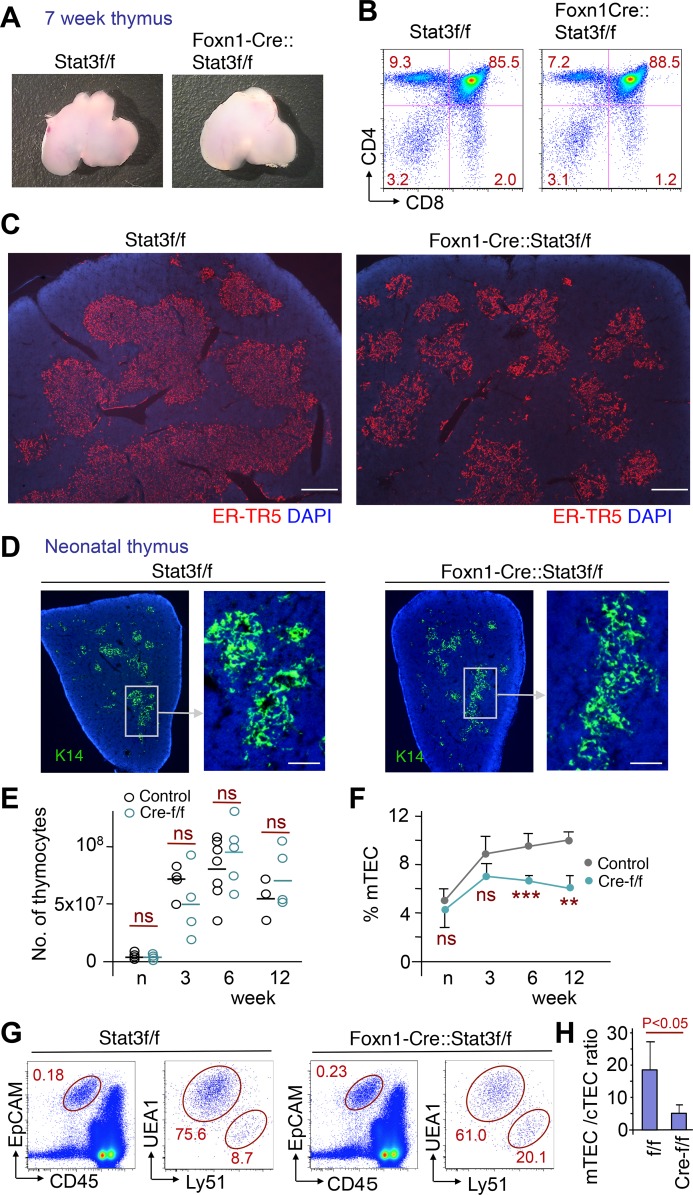
Medullary regions are severely affected in Foxn1-Stat3-CKO mice.(A) Macroscopy of the thymus derived from Stat3-flox/flox (Stat3f/f) and Foxn1Cre::Stat3f/f mice at 7 weeks of age. (B) Flowcytometric profiles of developing thymocytes derived from Stat3f/f and Foxn1Cre::Stat3f/f mice, at 7 weeks of age. (C) Cryostat sections of thymic tissue from Stat3f/f and Foxn1Cre::Stat3f/f mice (7 weeks of age) were stained with the mTEC specific antibody, ER-TR5 (red) and counterstained with DAPI (blue). Scale bars: 400 μm. (D) Cryostat sections of neonatal thymic tissue from Stat3f/f and Foxn1Cre::Stat3f/f mice were stained with antibody directed to K14 (green) and counterstained with DAPI (blue) Scale bars: 100 μm. (E) Total thymic cellularity of control (containing Cre-f/+ and f/f) and Foxn1Cre::Stat3f/f (Cre-f/f) mice at indicated ages. Bar stands for the average value of each experimental group. ns denotes a non-significant difference (P>0.1) in Student’s t test. (F) Changes in the proportional area of medullary regions in thymus tissue sections of control (containing Cre-f/+ and f/f, n = 8, 6, 7, 3 for neo, 3, 6, 12 week, respectively) and Foxn1Cre::Stat3f/f (Cre-f/f, n = 5, 4, 6, 5 for neo, 3, 6, 12 week, respectively) mice in the first 12 weeks of life. The area occupied by mTECs in thymus was quantitatively measured in sections stained with K14 antibody using Axiovision4 software (Carl Zeiss). Error bar stands for the standard deviation. ns denotes a non-significant difference (P>0.1) in Student’s t test. **;P<0.005, ***;P<0.0005. (G) Representative flow cytometric profiles showing frequencies of major TEC populations from 12 weeks old Stat3f/f and Foxn1Cre::Stat3f/f mice. EpCAM+CD45- fraction represents whole TEC population, and UEA1 vs Ly51 profile was displayed for the cells gated on EpCAM+CD45- fraction, where UEA1highLy51low and UEA1lowLy51high fraction were defined as mTEC and cTEC population, respectively. (H) Ratio of mTEC vs cTECs in flow cytometric analysis of control (containing Cre-f/+ and f/f, n = 4) and Foxn1Cre::Stat3f/f mice (n = 5) at 12 weeks of age is shown.